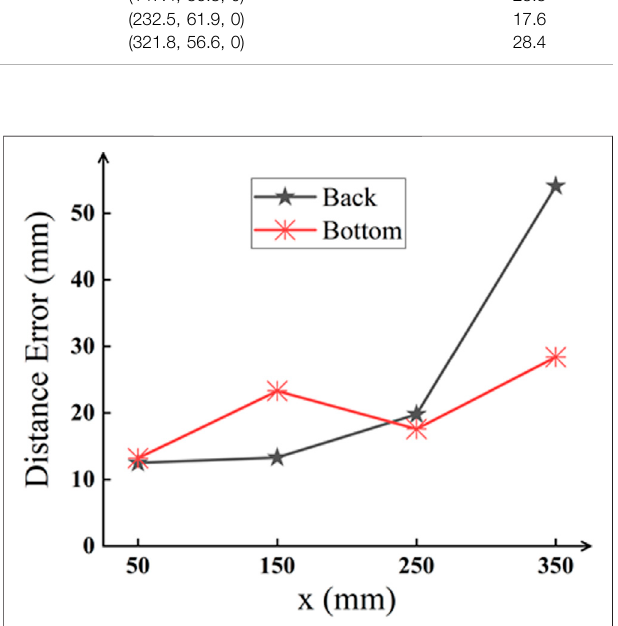
FIGURE 14 | Relationship between the impact locations and the distance